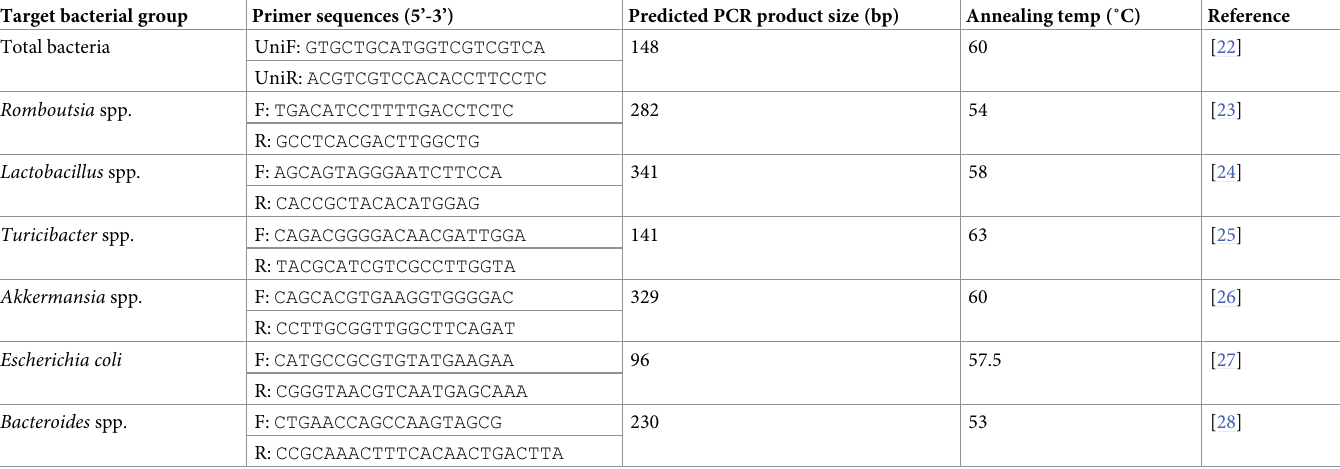
Table 2. qPCR primer information and predicted product size. Target bacterial